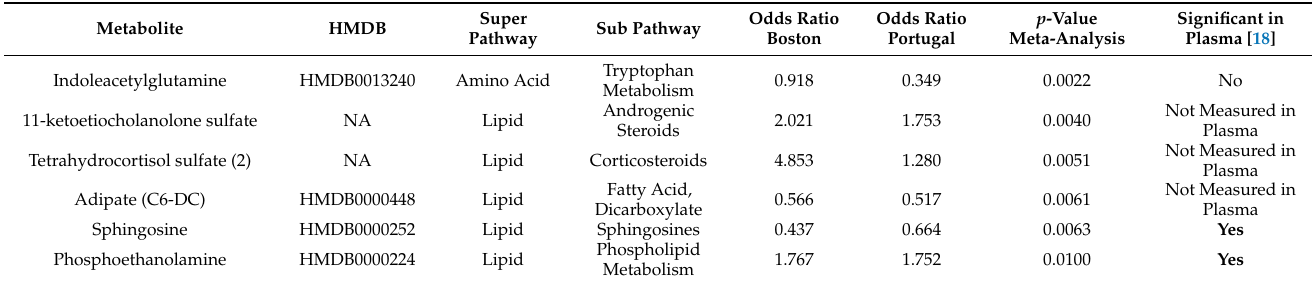
Table 2. Urinary metabolites differing significantly across severity stages ( p <